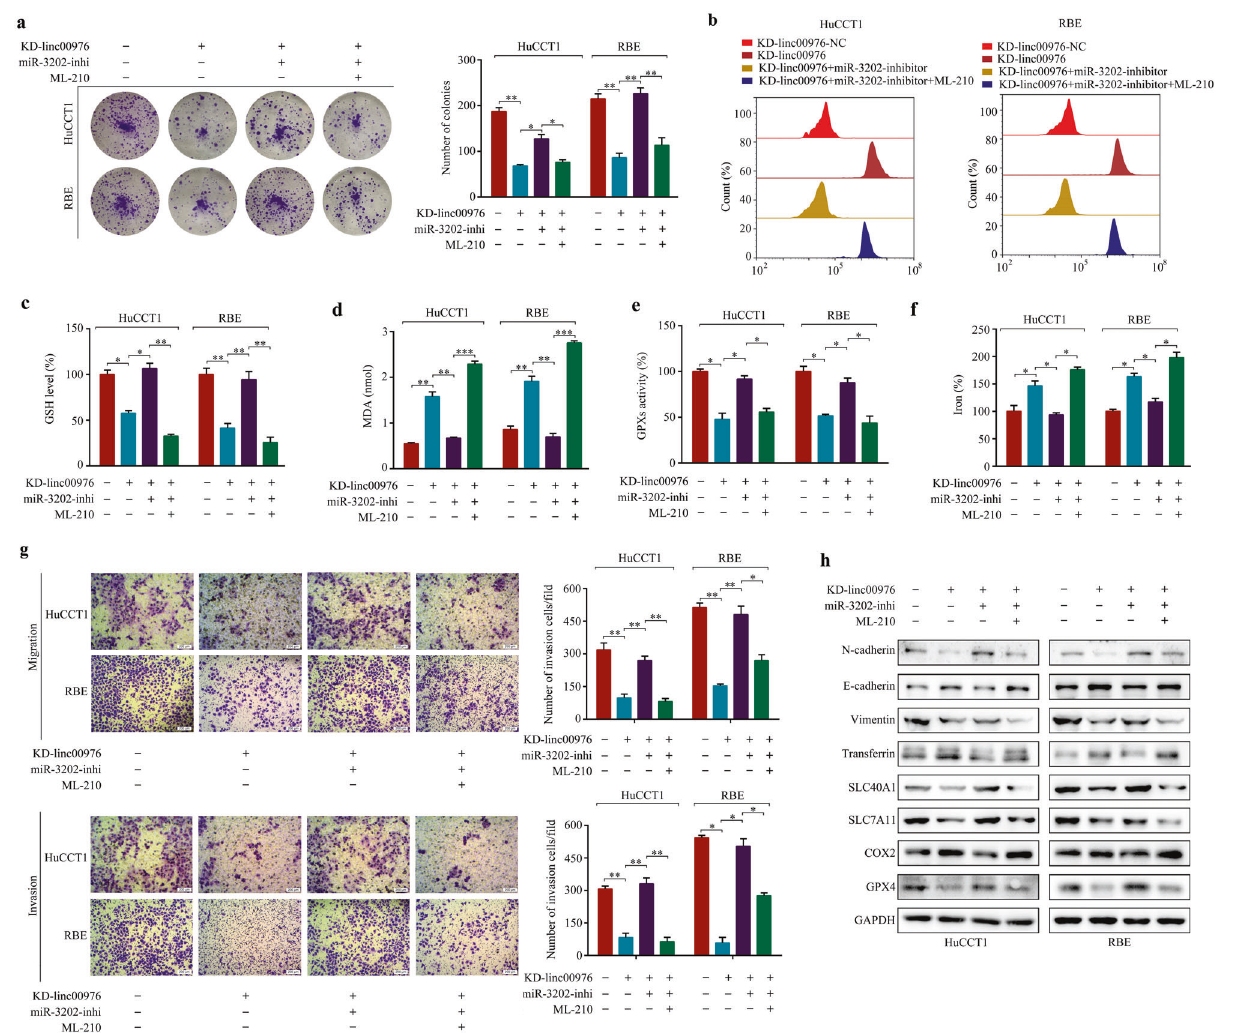
effect of the linc00976/miR-3202/GPX4 axis on cell proliferation. b – f Effects of the linc00976/miR-3202/GPX4 axis on ROS, GSH, MDA, iron progression, and GPX activities in CCA cells. g Transwell migration and Matrigel invasion assays evaluated the effect of the